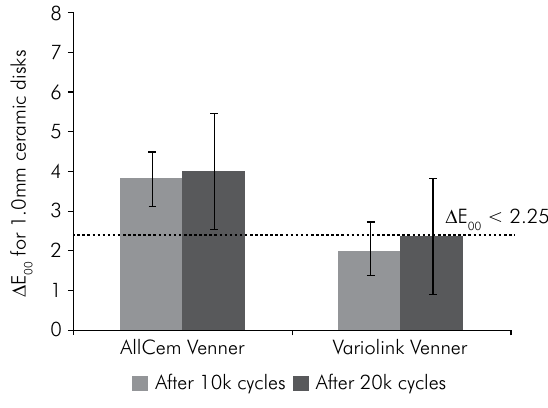
Figure 2. rE values for analysis of color stability of 1.0 mm- 00 thick bonded ceramic disks after 10,000 and 20,000 thermal cycles. rE values lower than 2.25 were considered clinically 00 imperceptible * indicates significant differences after 10,000 and 20,000 thermal cycles in the same